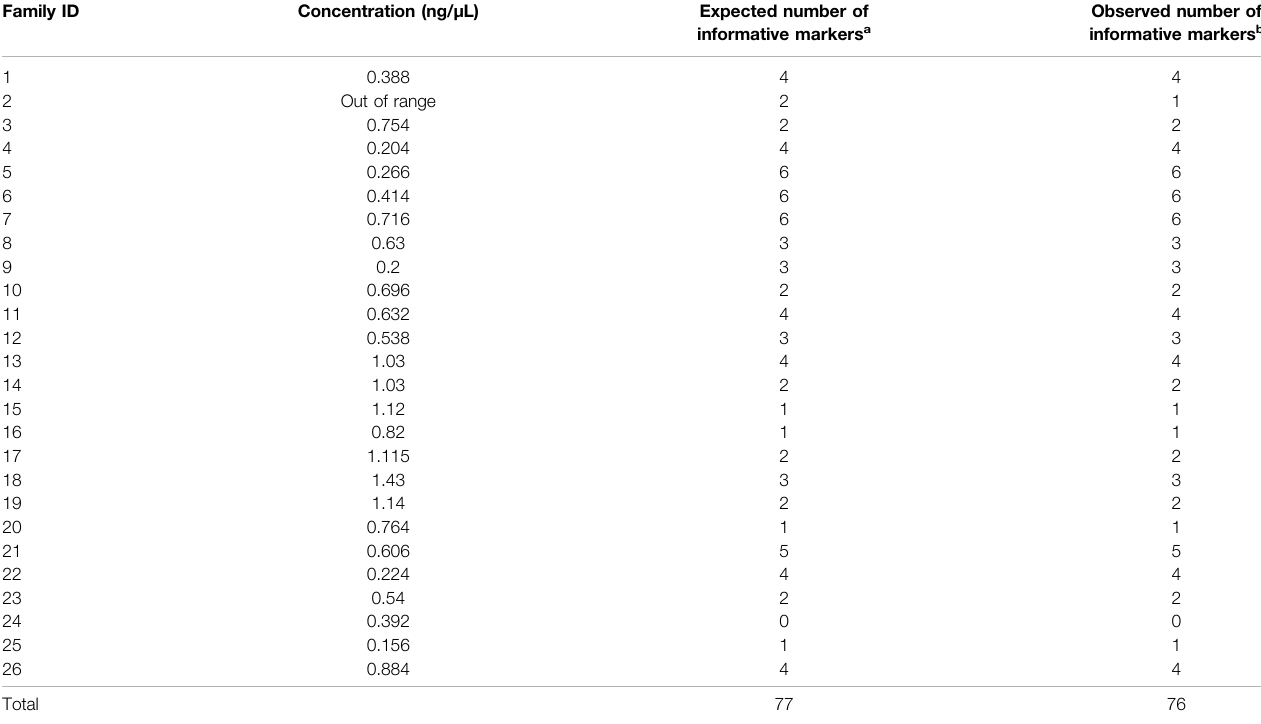
TABLE 1 | The concentration of the cell-free DNA (cfDNA). Family ID Concentration (ng/ μ L) Expected number of